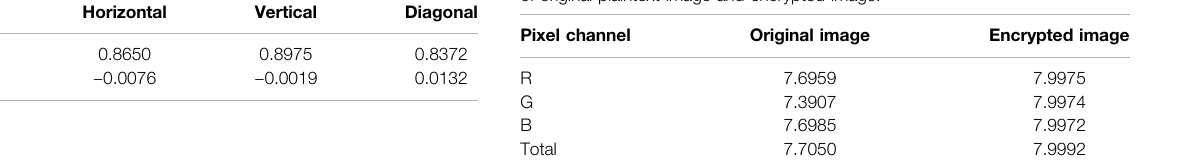
TABLE 6 | The results ofinformation entropy about R , B , G and total pixel channel of original plaintext image and encrypted